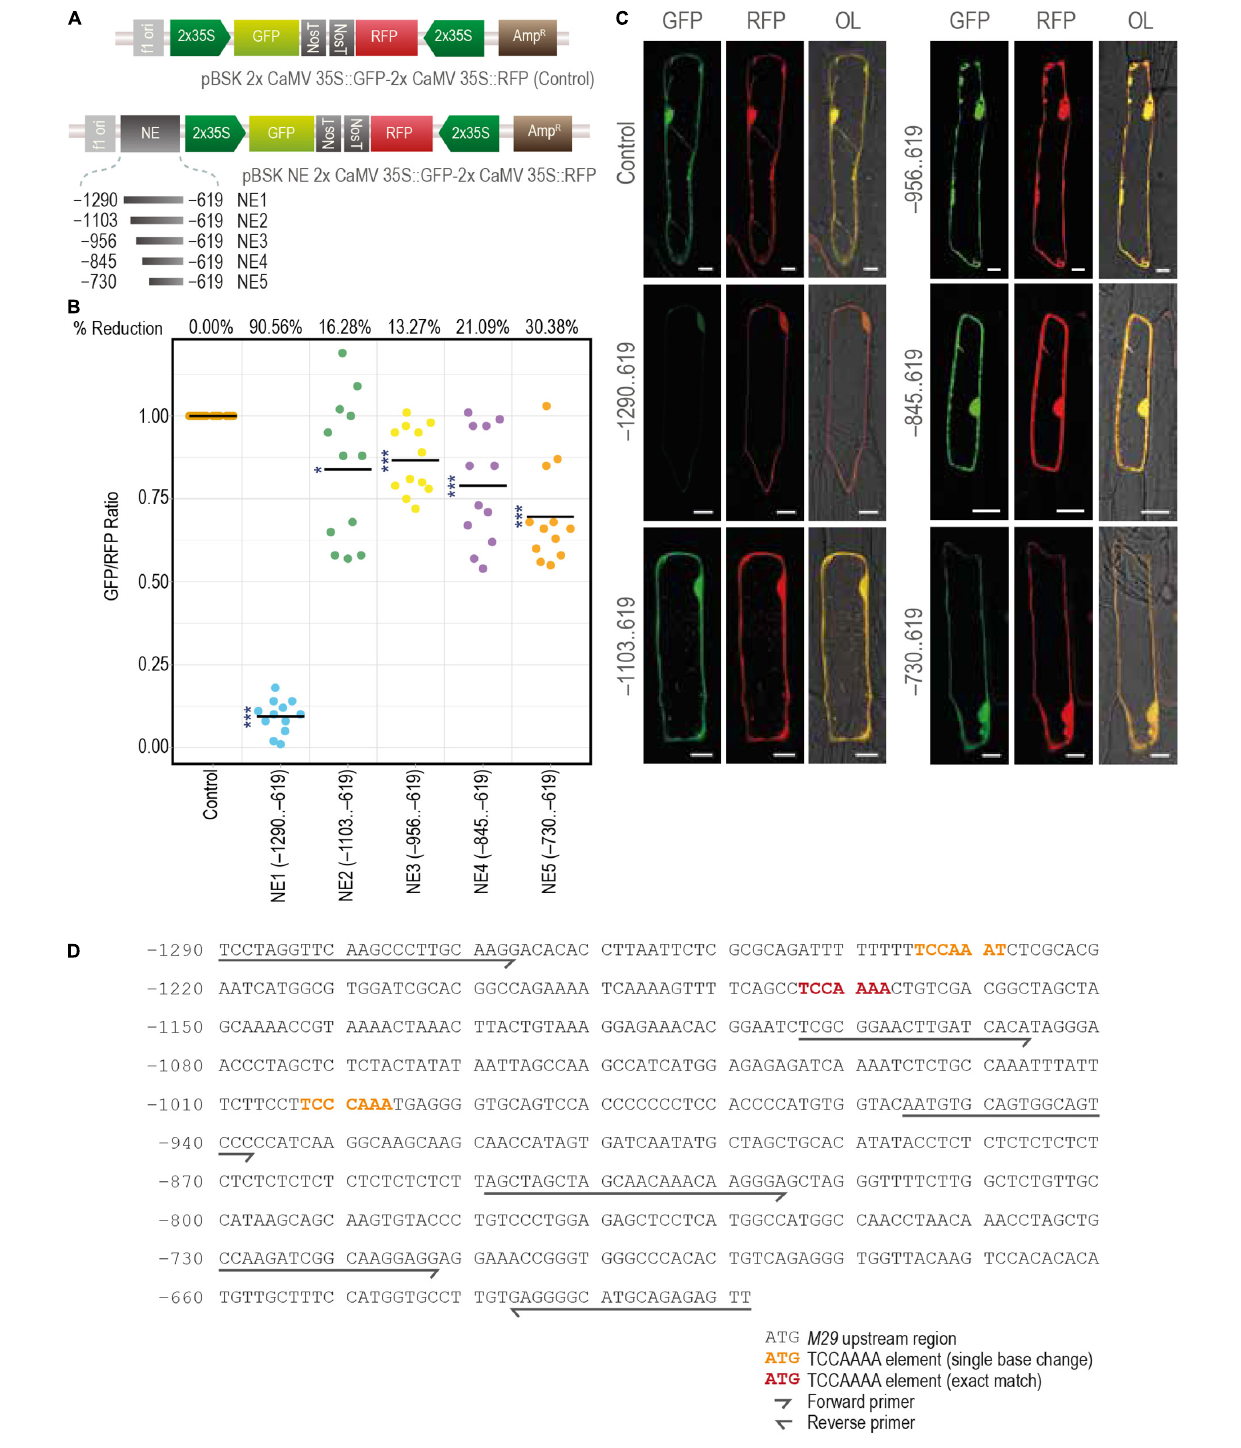
FIGURE 11 | Characterization of the distal negative element. (A) The constructs used for the bombardment in the onion peel cells. (B) The scatter plot constructed using the online tool PlotsOfData (https://huygens.science.uva.nl/PlotsOfData/) shows the measured GFP/RFP ratio of the control vector containing both the GFP and RFP under same but individual 2x CaMV 35S promoter and the vectors containing the sequential deletions of the negative element region, from –1290..–619. The readings of the control vector samples were normalized to 1, and for the other vectors, the values were scaled accordingly. The percentage reduction is mentioned at the top of the graph for each corresponding construct. Here, N = 12, the asterisks represent Student’s t -test p -value, *** represents < 0.001,